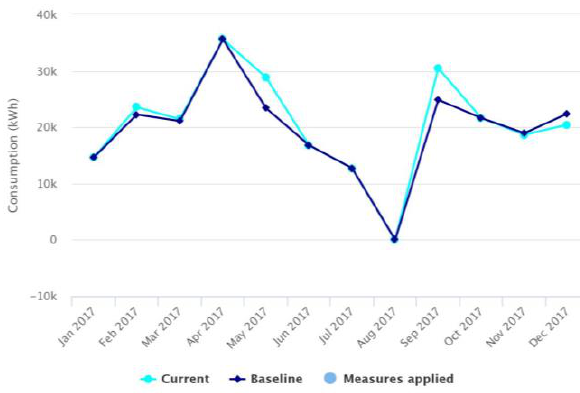
Figure 5. Information System Application of the electricity consumption of CIPFP Blasco